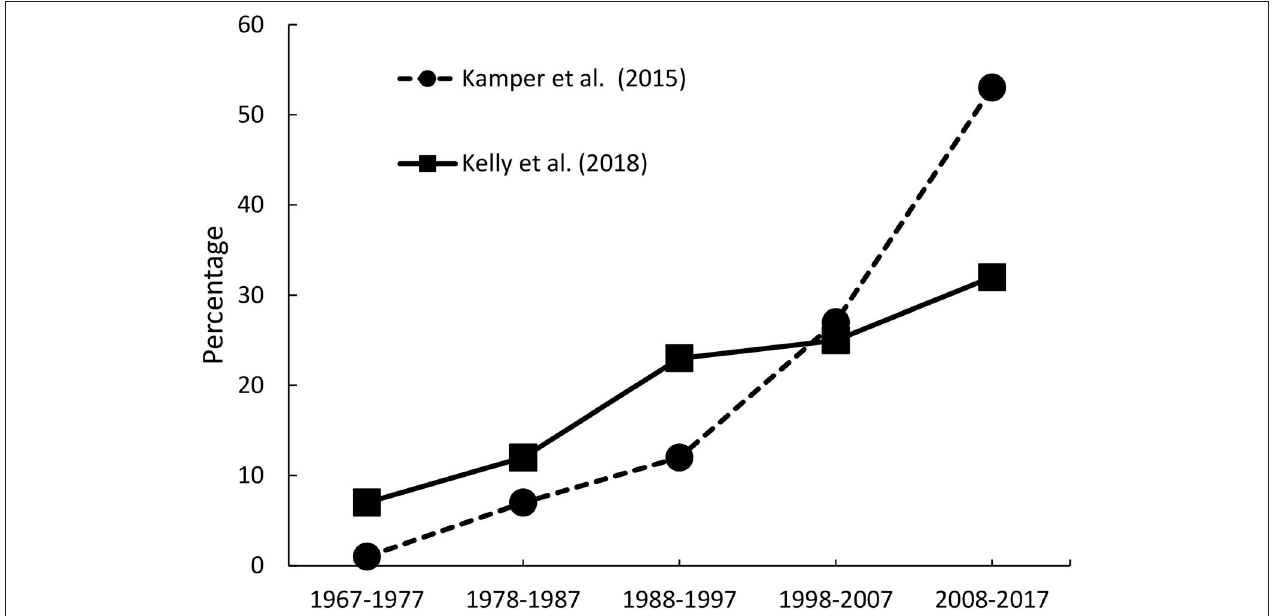
FIGURE 1 | Percentage of RCT studies, published across the past 40 years, falling into each successive 10-year period, reported by Kamper et al. (1) and Kelly et al. (